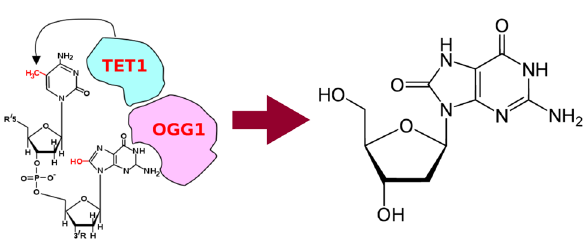
Figure 6. Formation of 8-oxodG out of guanine from a DNA sequence with intervention of TET1 and OGG1. 8-oxodG is a sensitive marker of DNA damage due to hydroxyl radical attack at the C8 of guanine. This damage is mutagenic and promotes